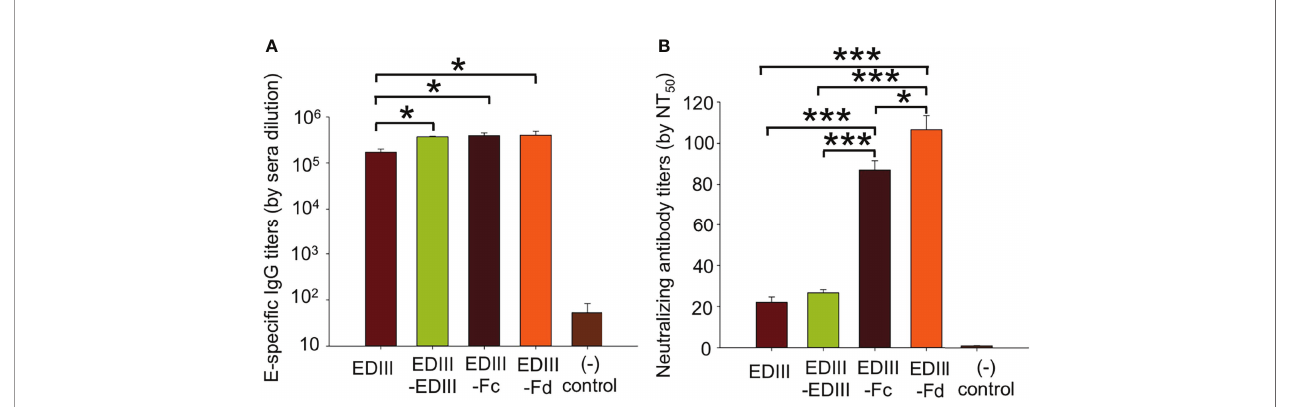
FIGURE 3 | Immunogenicity of recombinant JEV EDIII fragments. (A) Measurement of the titers of total IgG antibodies in sera of mice immunized with one of the EDIII fragments. To this end, ELISA was carried out between the full-length JEV E protein and mouse sera. The titers of JEV E-speci fi c total IgG antibodies are expressed as the endpoint dilutions that remain positively detectable. (B) Measurement of the titers of neutralizing antibodies in sera of mice immunized with one of the EDIII fragments. To this end, plaque reduction neutralization assay was performed to detect the ef fi ciency of mouse sera in inhibiting the formation of JEV plaques. The titers of neutralizing antibodies are presented as the highest dilution of sera that result in a complete inhibition of virus infectivity in at least 50% of the wells (NT 50 ). In both panels, PBS was used as a control, and the data are presented as mean ± SD of fi ve mice in each group, * P < 0.05, *** P <